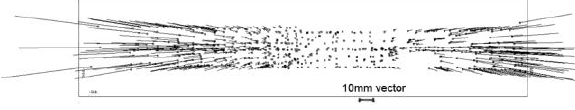
Figure 5. Panoramic correction – vectors enlarged